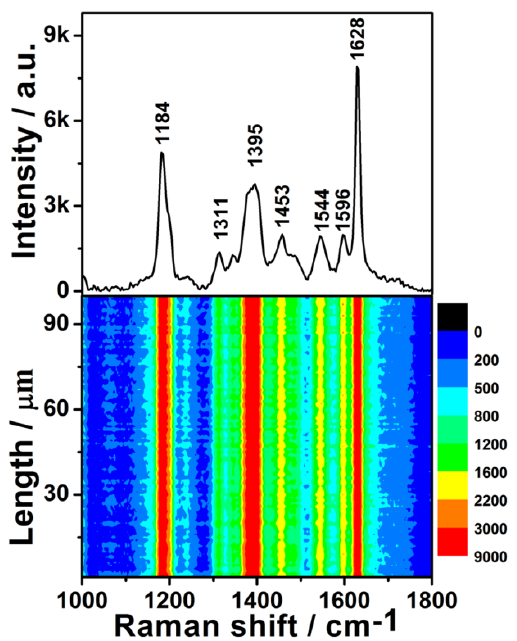
Figure 5. Upper: the SERS spectrum of 1 × 10 −7 M Crystal violet (CV) solution on the Ge wafer grafted with Ag–Pt nanoparticles. Lower: the SERS contour from line mapping of 100 spots.